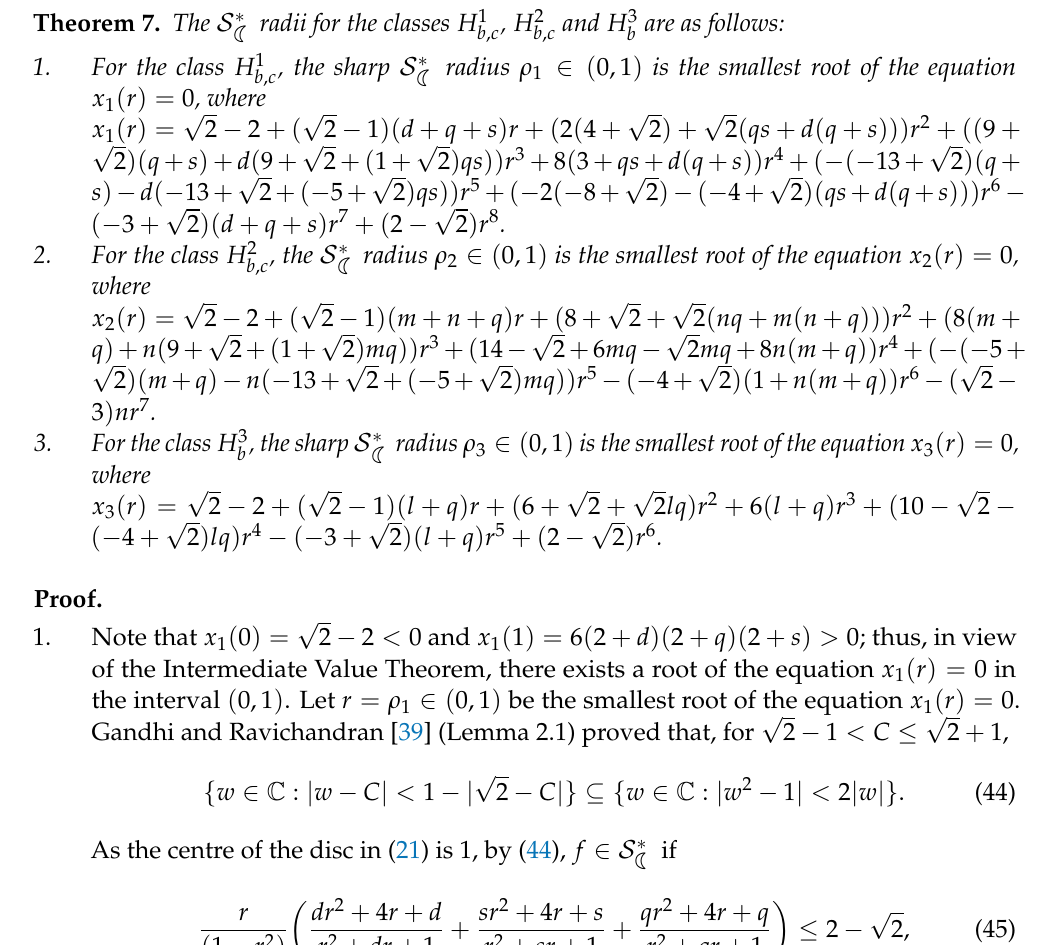
, H 2 and H 3 (b = 1, c = 1, q = b , c b , c b